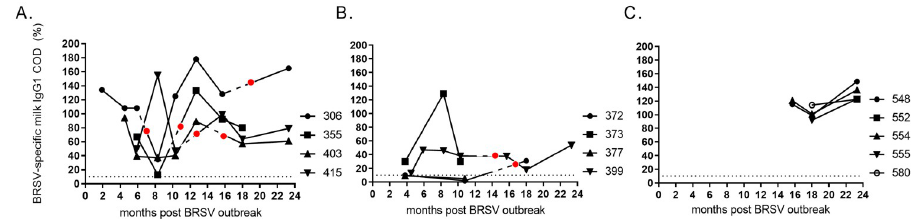
Fig 9. Kinetics of BRSV-specific total IgG1 in milk from cattle of different age and production status. At the time of a BRSV outbreak (in January 2016, month 0) the cattle were (A) 23–30 months old ( < 6 months gestation), (B) 24– 26 months old ( > 6.5 months gestation), or (C) 7–11 months old. Corrected optical density (COD) values are presented as percentage of a positive control serum. Broken lines represent dry periods and red circles are timepoints for calving.